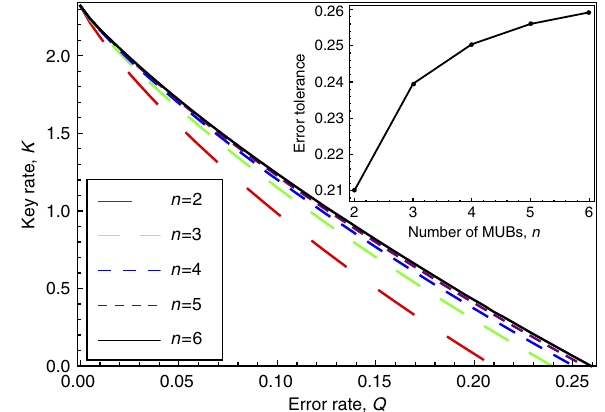
Figure 4 | Protocol where Alice and Bob each use n MUBs. The key rate is plotted for various n A {2, 3, 4, 5, 6} and for d A ¼ d B ¼ 5. This is an unstructured protocol, since for intermediate values of n the symmetry group and hence the key rate is unknown. However, our numerics provides the dependence of key rate on error rate for any n , as shown. The inset shows the error tolerance—the smallest error rate that makes the key rate vanish—as a function of n . Note that the largest jump in the error tolerance occurs from n ¼ 2 to n ¼